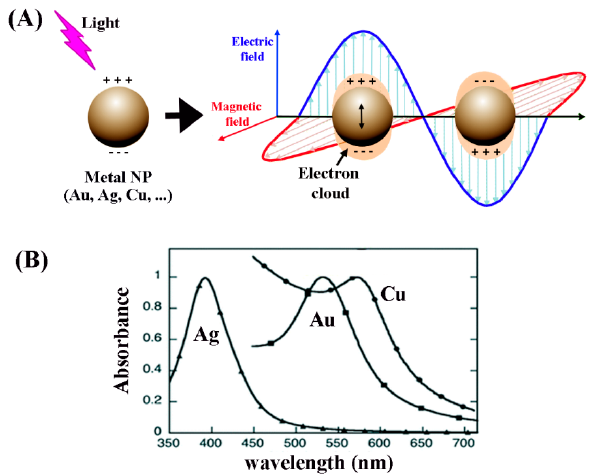
Figure 13. ( A ) An illustration of a localized surface plasmon around a metal nanoparticle; ( B ) Typical examples of surface plasmon peaks appearing in the visible range for the metals of Ag, Au, and Cu.